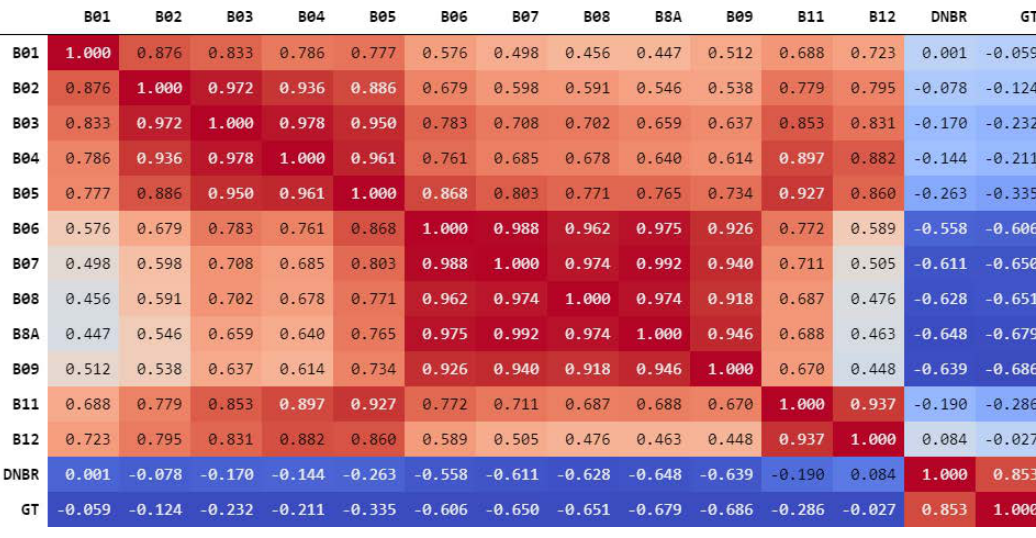
Figure 2. Correlation Matrix computed on burned areas. Spectral Bands B01–B12 refer to the post-fire Sentinel-2 acquisition, dNBR is the Delta Normalized Burn Ratio, and GT is the severity level target variable (i.e., the Copernicus EMS grading map Ground Truth).